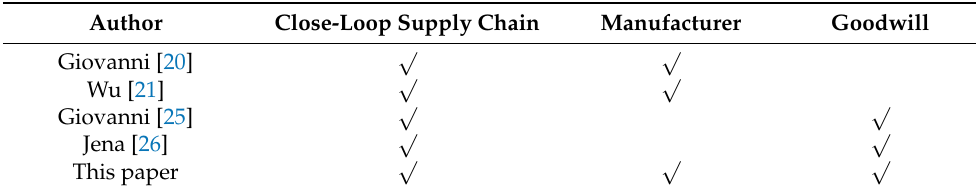
Table 1. Some literature most relevant to this